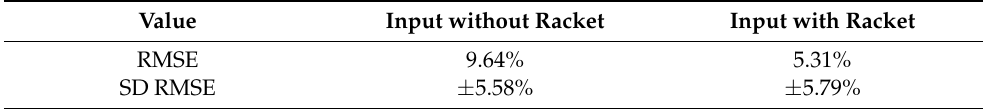
Table 6. Obtained Values for